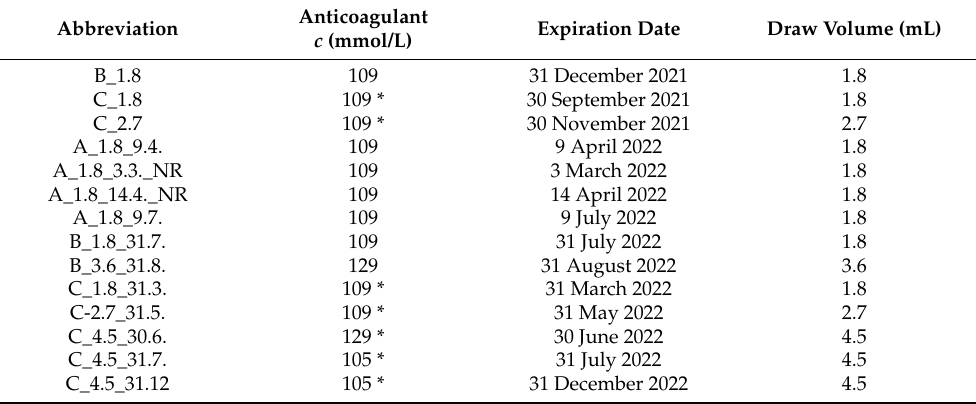
Table 8. Characteristics of the examined evacuated citrate or buffered citrate blood-collection